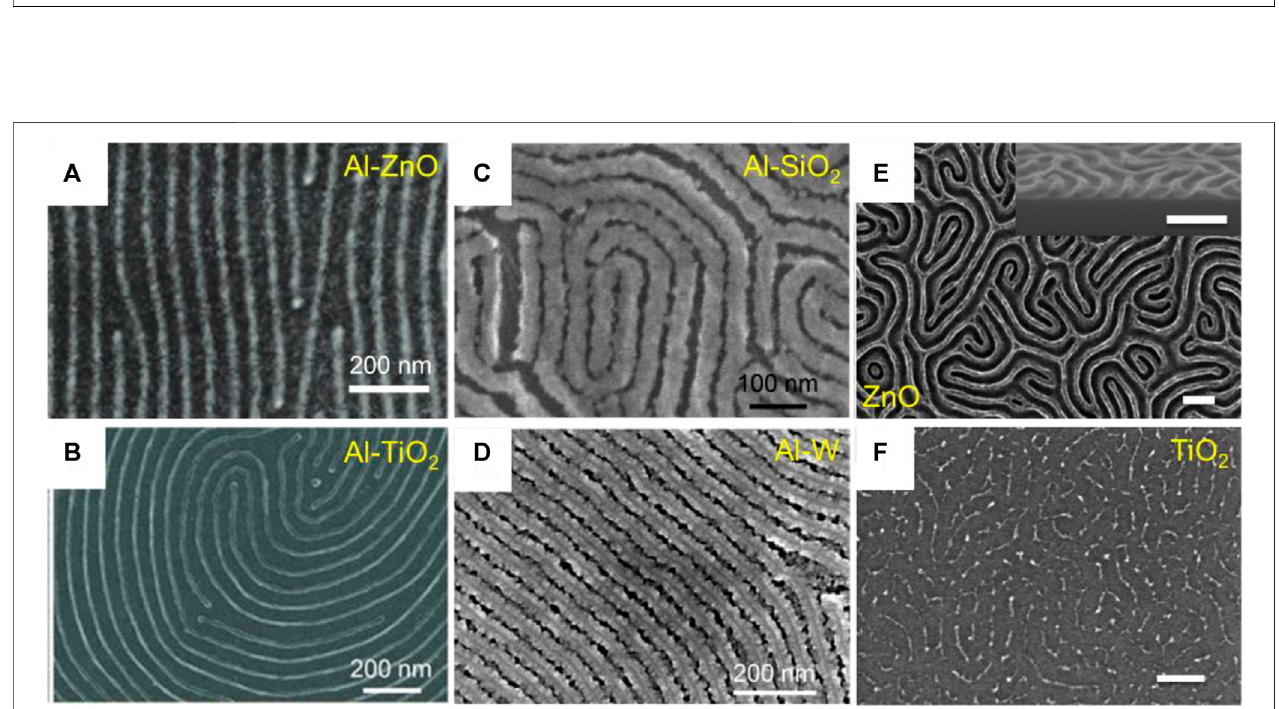
FIGURE 5 | a) SEM micrographs of in fi ltration-synthesized Al primed (A) ZnO; (B) TiO 2 ; (C) SiO 2 ; (D) W; SEM images of (E) ZnO; and (F) TiO2 nanowires obtained via in fi ltration into the PS domain of UV/O 2 modi fi ed PS- b -PMMA BCP fi lm. Reproduced with permission from ref (Subramanian et al., 2019).